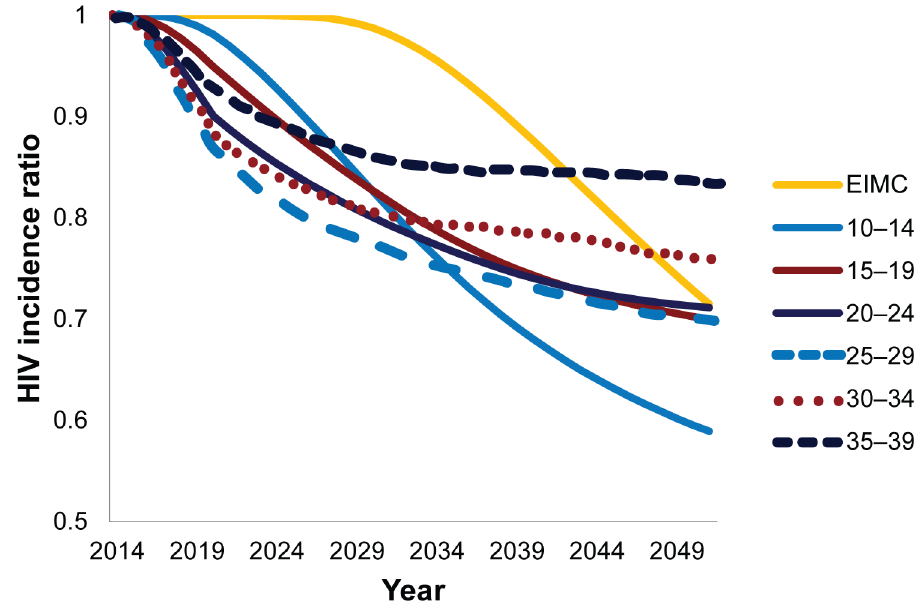
Fig 1. Modeled relative reduction in HIV incidence with provision of VMMC by age group, 2015 –